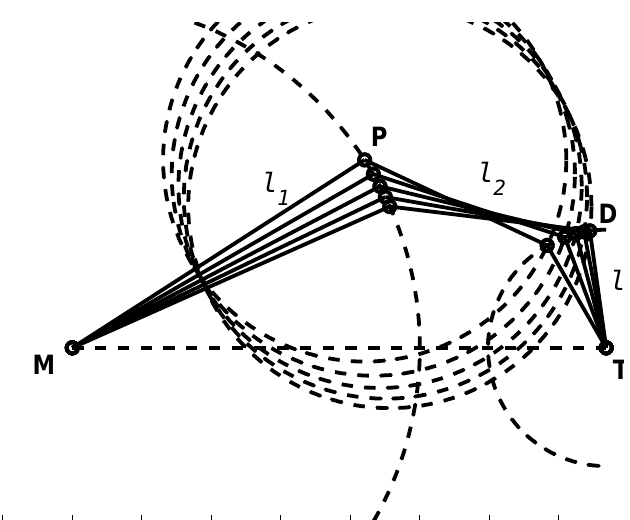
Figure 2. For a fixed base position of the metacarpal phalangeal joint M , there are infinitely many solutions of θ , θ and θ , or in other words, P and D , to place the fingertip MCP PIP DIP T into a particular position, in addition to the knowledge of the lengths of the phalangeal bones ( l , l and l ). 1 2 3